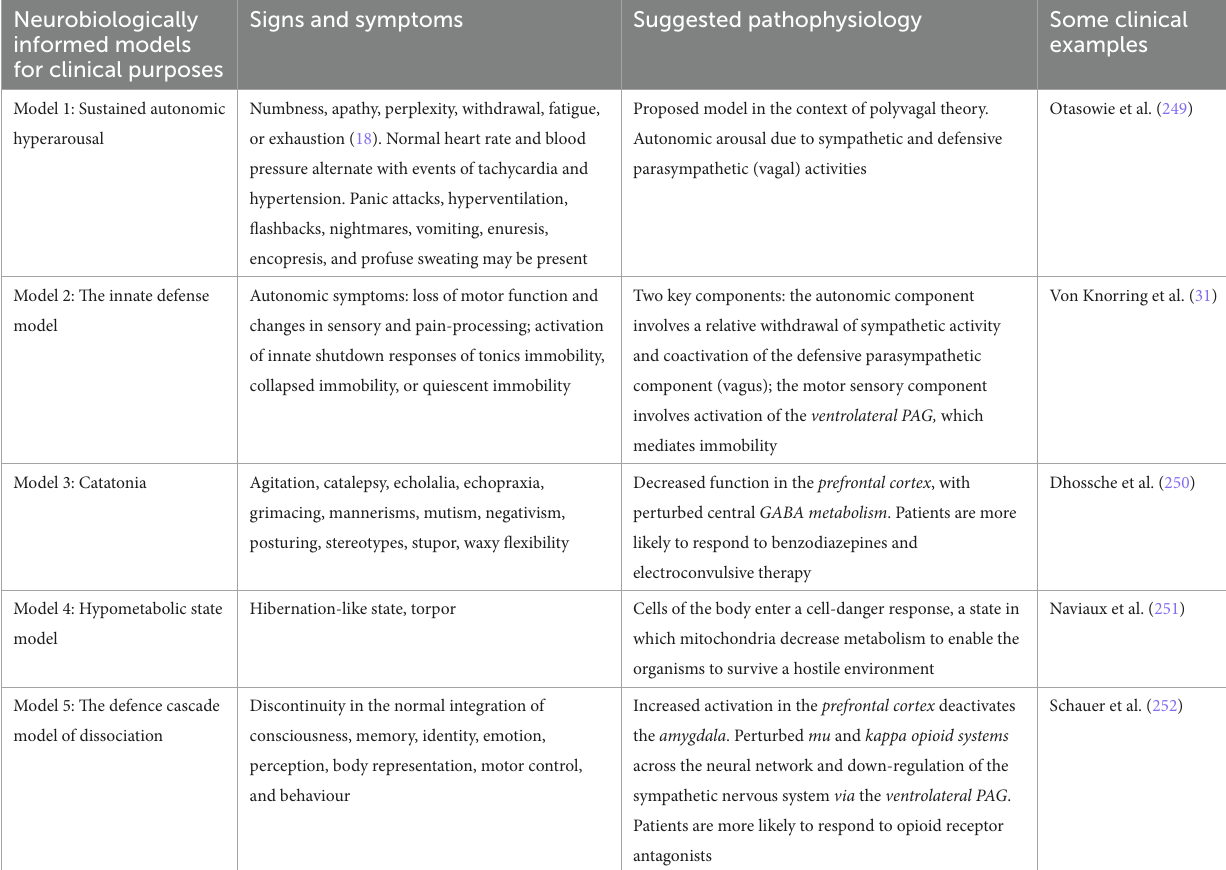
TABLE 1 Five neurobiologically informed clinical models following the work of Kozlowska et al. (29). Neurobiologically informed models for clinical